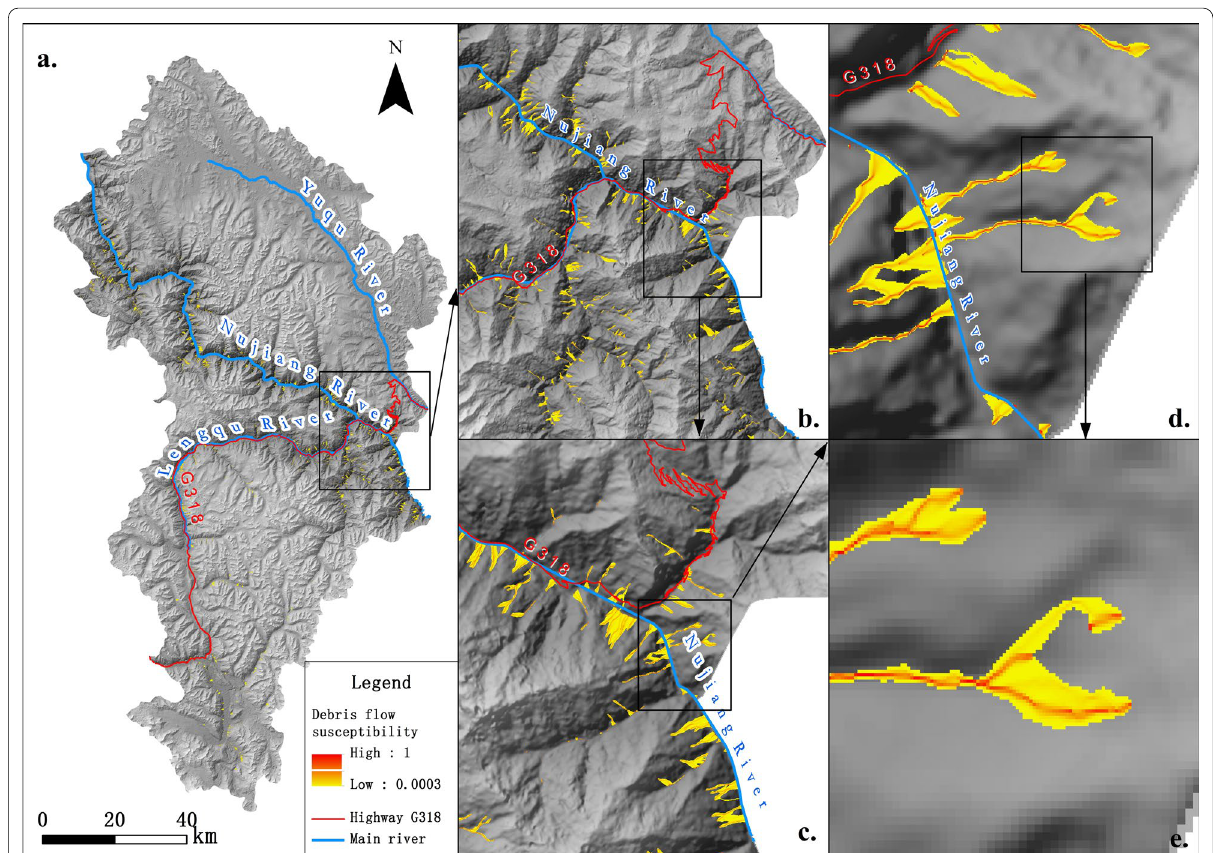
Fig. 8 Susceptibility distribution of debris flow at different scales. a Susceptibility of debris flow in Basu County at large scale; b Susceptibility of debris flow in part of Nujiang River basin in Eastern Basu County; c Susceptibility of debris flow at the township scale; d Susceptibility of debris flow at the village level; e Debris flow susceptibility of a single debris